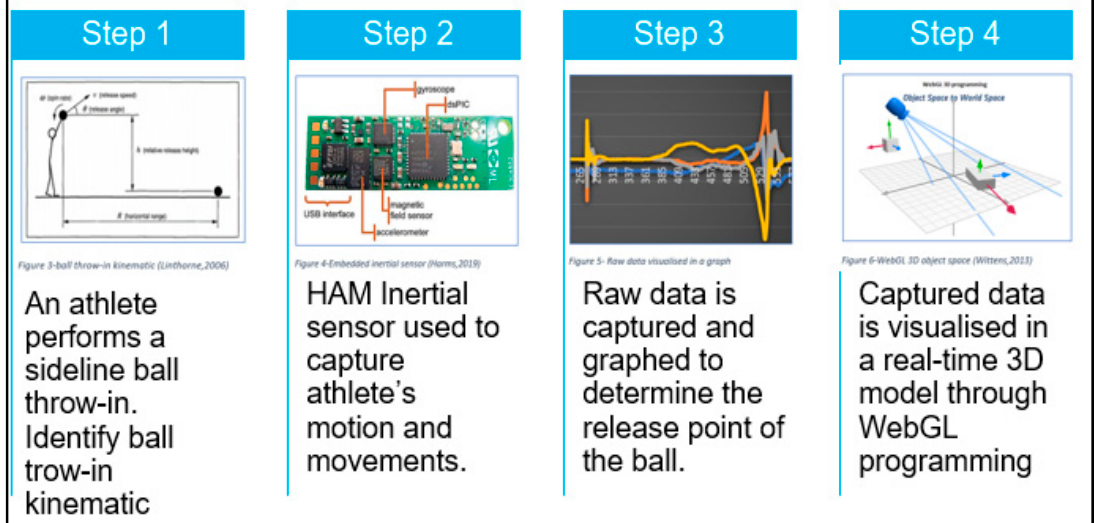
Figure 2. Development phase that demonstrates the process of data extraction from the throw, to comparative data capture